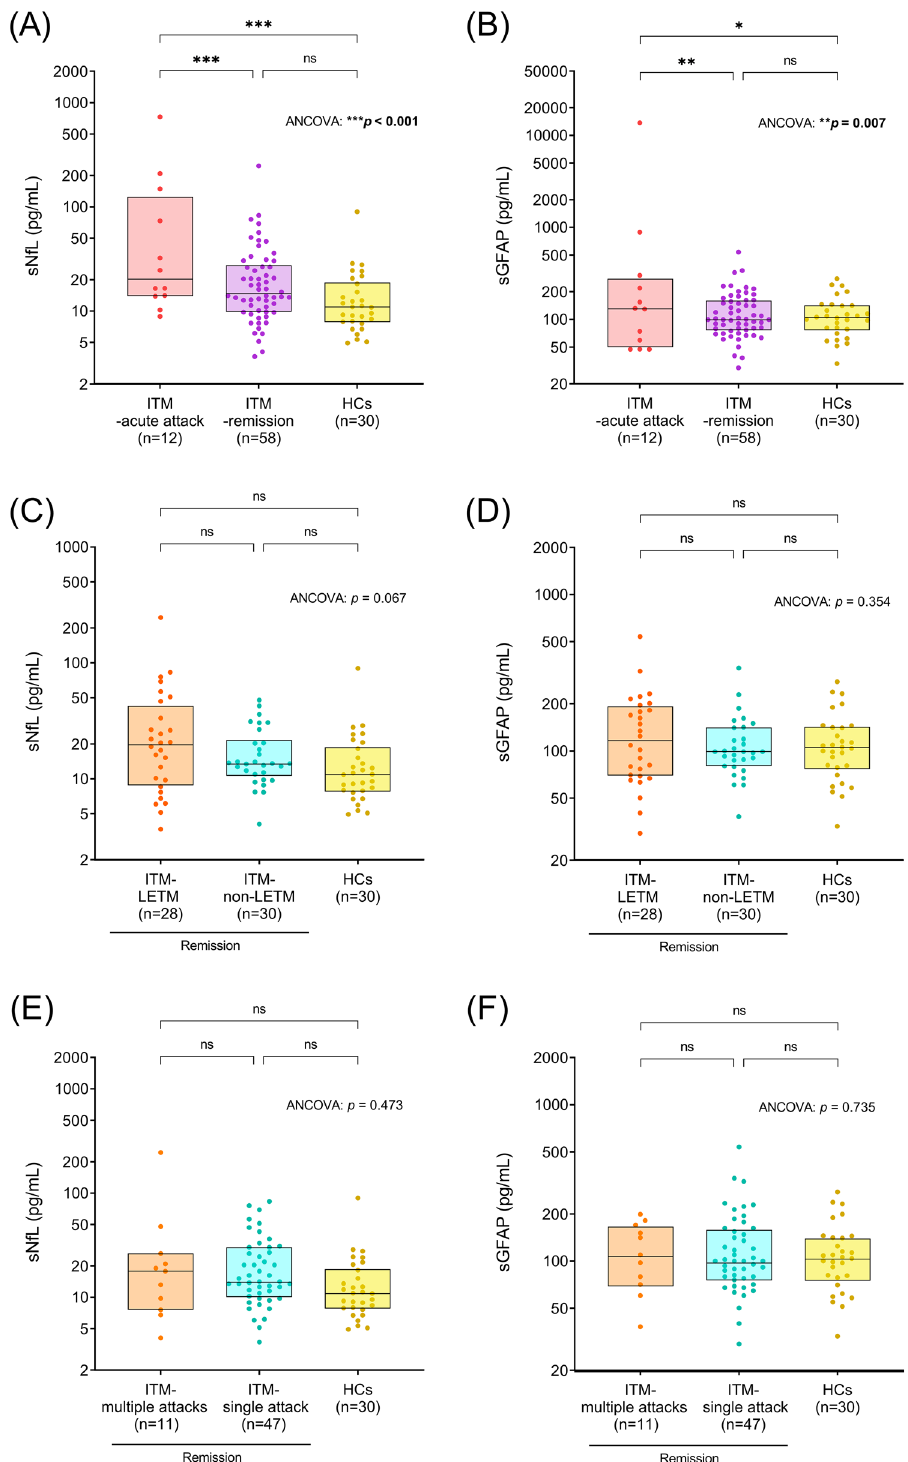
Figure 2. Serum biomarker levels in ITM patients and healthy controls. ( A , B ) sNfL and sGFAP levels of ITM patients (n = 70) and healthy controls (n = 30) were compared. “Acute attack” (n = 12) stands for a clinical attack within the last two months. ( C , D ) sNfL and sGFAP levels were compared between ITM patients in the remission phase who experienced LETM (n = 28) and those who did not experience LETM (n = 30). ( E , F ) sNfL and sGFAP levels were compared between ITM patients in the remission phase who experienced a single attack (n = 47) and those who experienced multiple attacks (n = 11). The boxes represent medians and interquartile ranges (IQR). Age was considered as a covariate in the analyses. p values with statistical significance (* p < 0.05, ** p < 0.01 and *** p < 0.001) are presented in bold. sNfL: serum neurofilament; sGFAP: serum glial fibrillary acidic protein; ITM: idiopathic transverse myelitis; HCs: healthy controls; LETM: longitudinally extended transverse myelitis; ANCOVA: analysis of